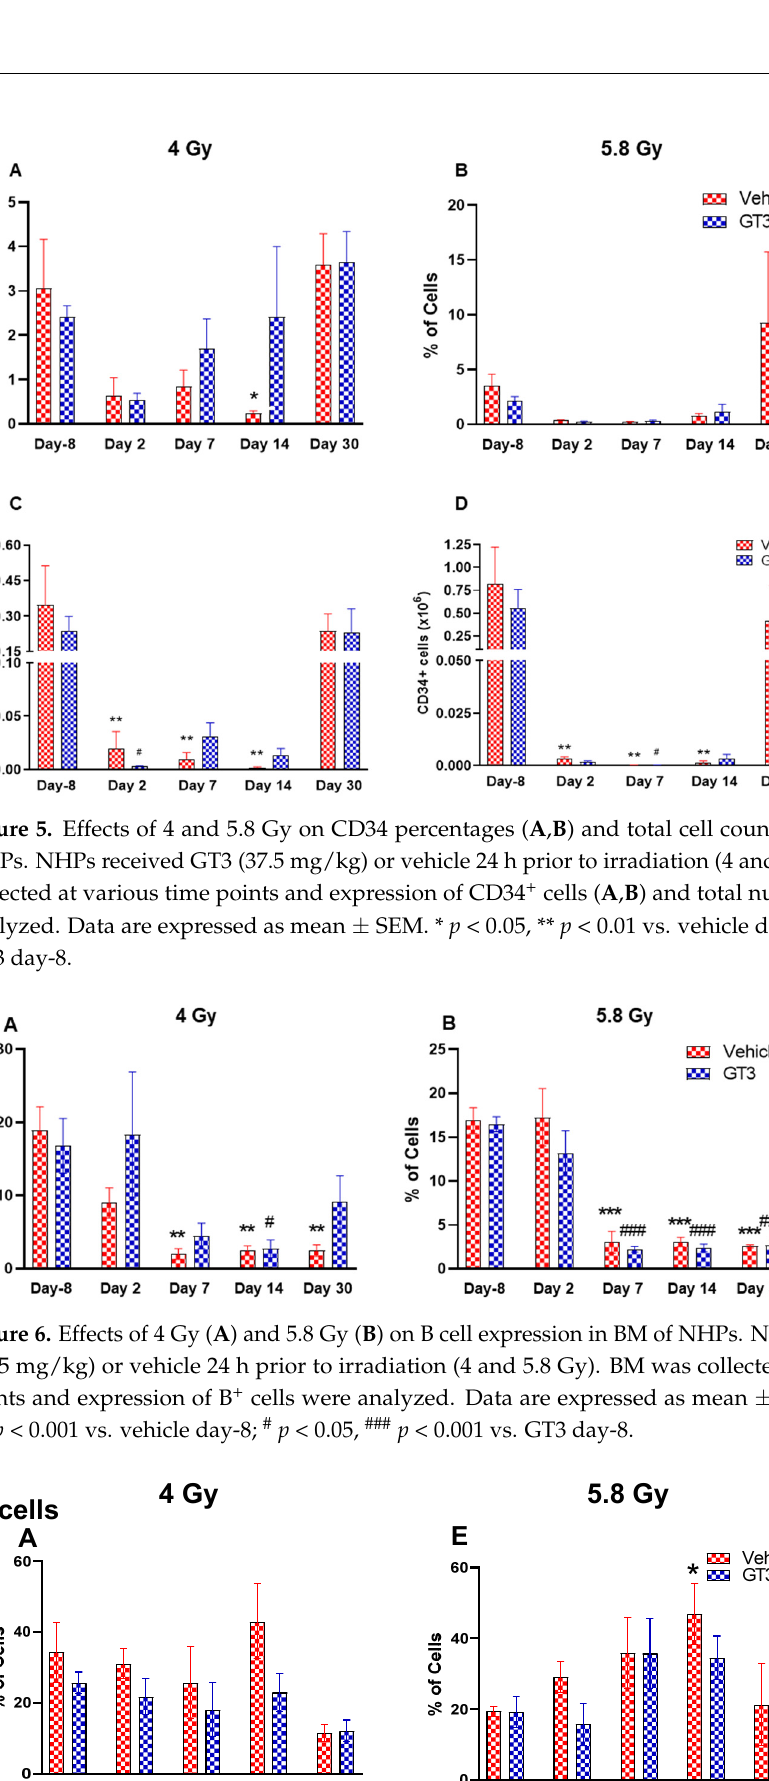
Figure 4. Effects of 4 Gy (A) and 5.8 Gy (B) on CD45 expression in BM of NHPs. NHPs received GT3 (37.5 mg/kg) or vehicle 24 h prior to irradiation (4 and 5.8 Gy). BM was collected at various time points and expression of CD45 + cells were analyzed. Data are expressed as mean ± SEM. ** p < 0.01,